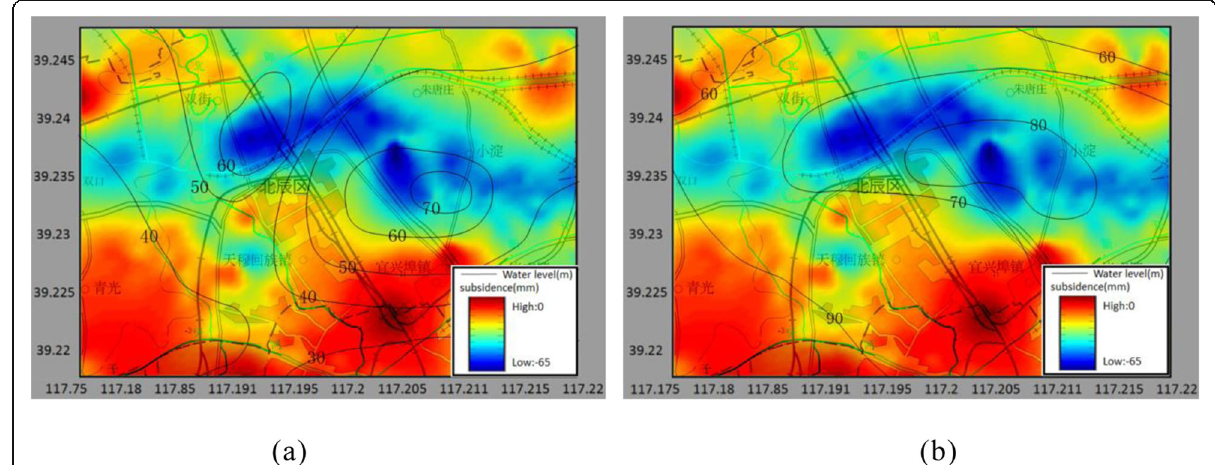
Fig. 11 Coupled analysis diagram of water level and land subsidence in Beichen District. a Water-level contour map of confined aquifer II on the subsidence map. b Water-level contour map of confined aquifer III on the subsidence